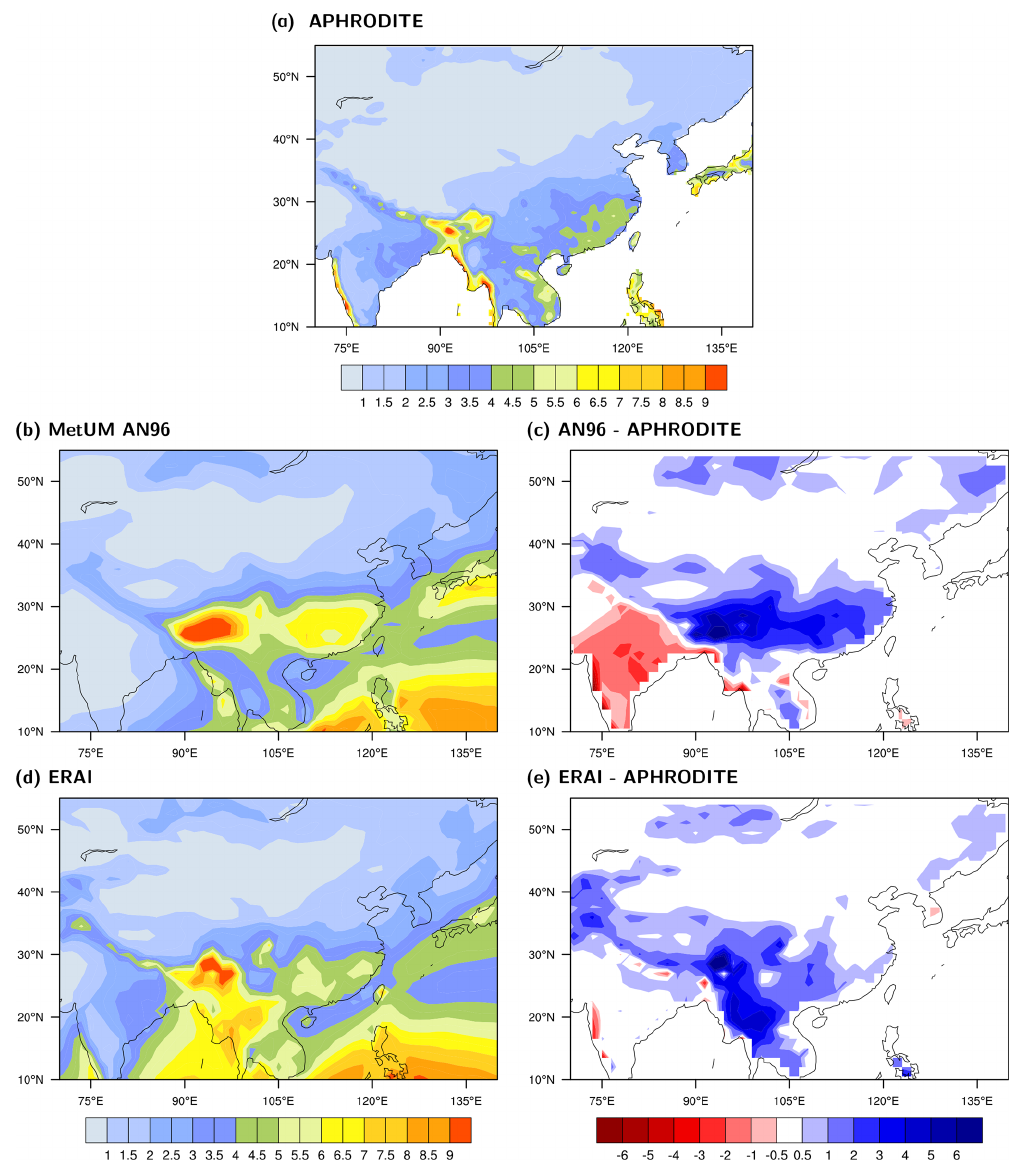
Figure 2. Annual mean precipitation of (a) APHRODITE, (b) MetUM AN96 and (d) ERA-Interim, and differences (c) between AN96 and APHRODITE, and (e) between ERA-Interim and APHRODITE. The annual precipitation is averaged over 1982–2012 (units: mmd − 1 ).